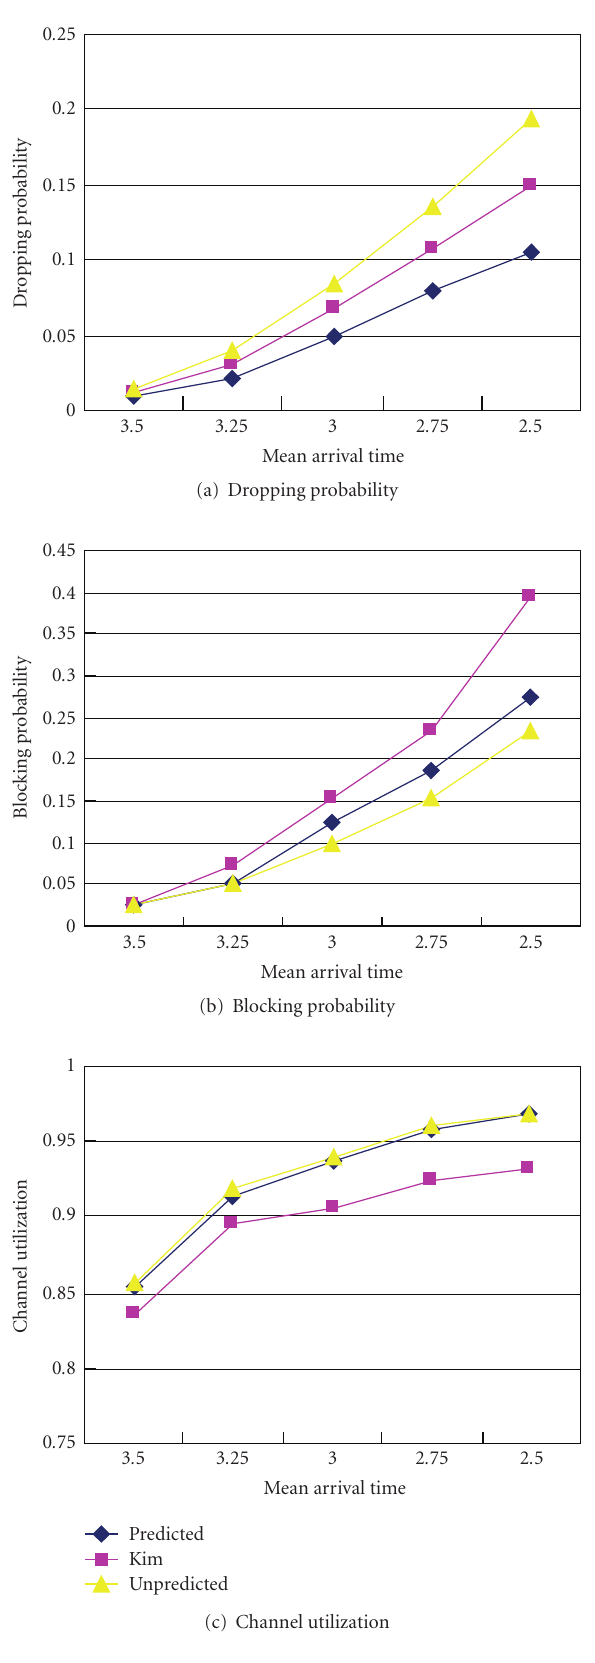
Figure 2: Simulation results of hando ff